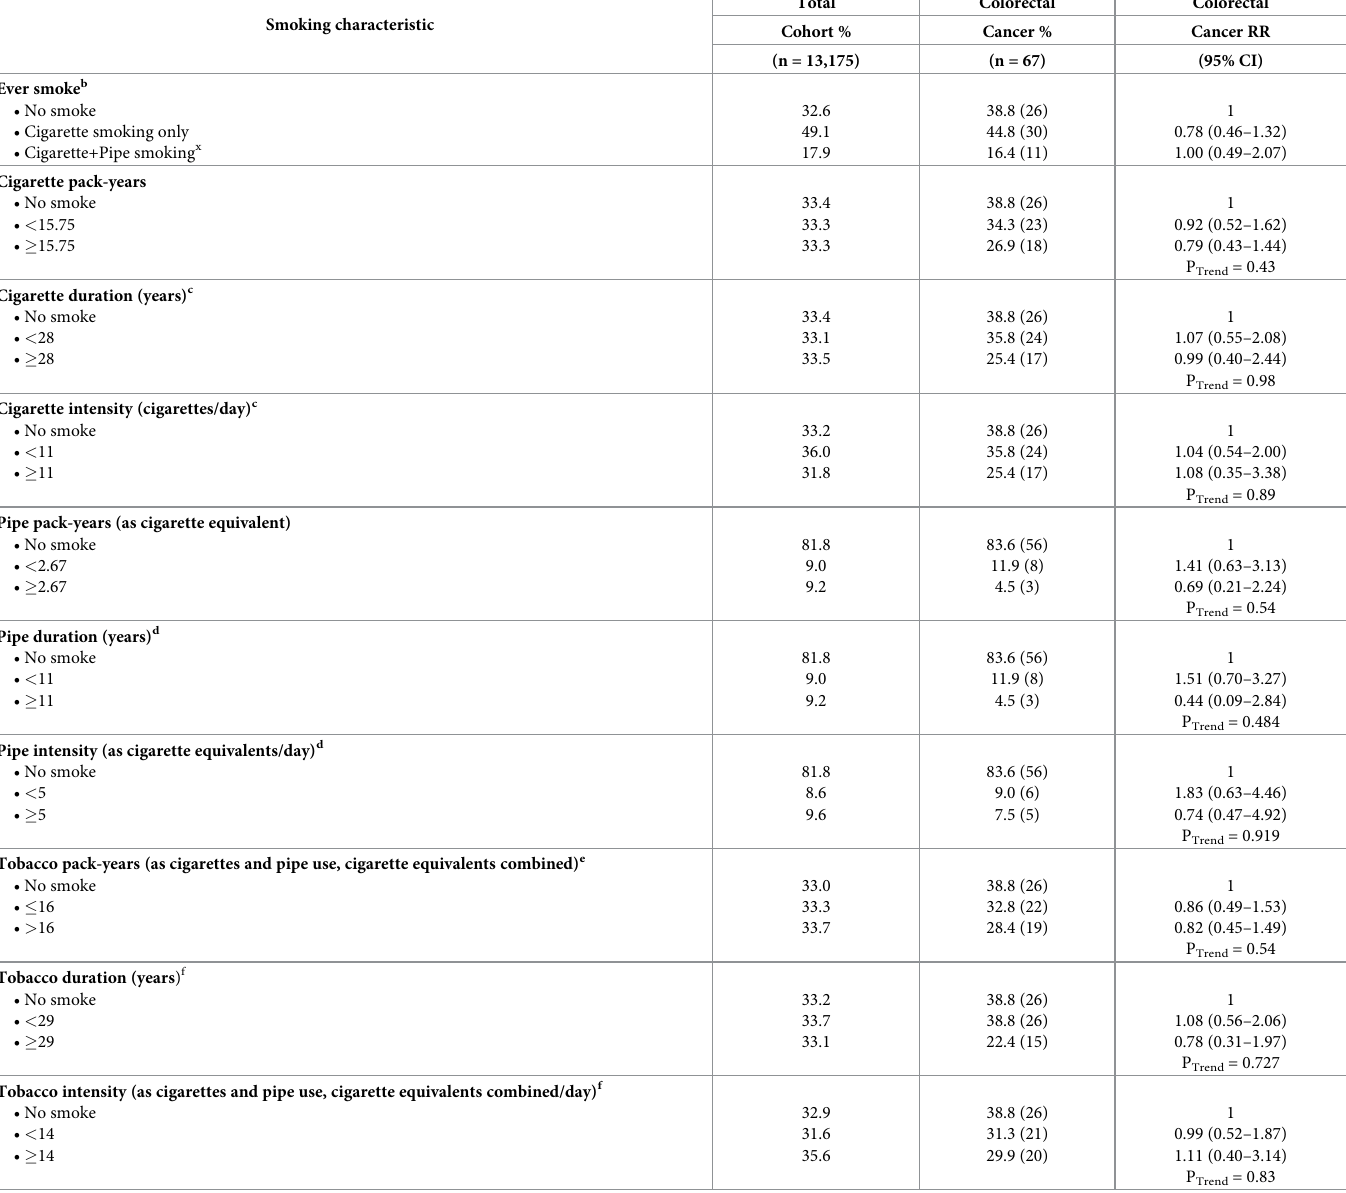
Table 2. Age-adjusted RRs and 95% CIs for colorectal cancer in men by baseline smoking characteristics a